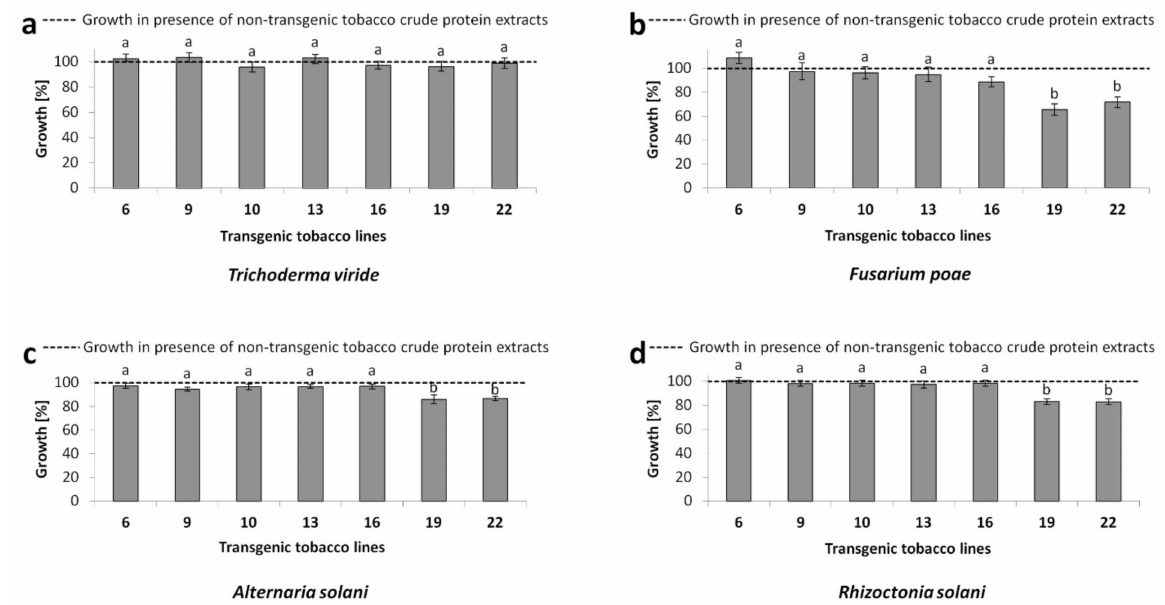
Figure 6. Antifungal activity effect of 100 µ g of crude protein extracts isolated from transgenic tobacco lines 6, 9, 10, 13, 16, 19, and 22 and the non-transgenic control on the fungal growth of filamentous fungi ( a ) T. viride , ( b ) F. poae , ( c ) A. solani, and ( d ) R. solani grown in liquid potato dextrose broth. Values represent the mean of five biological and three technical replicates (Supplementary Table S6) a,b difference at p < 0.05 from the